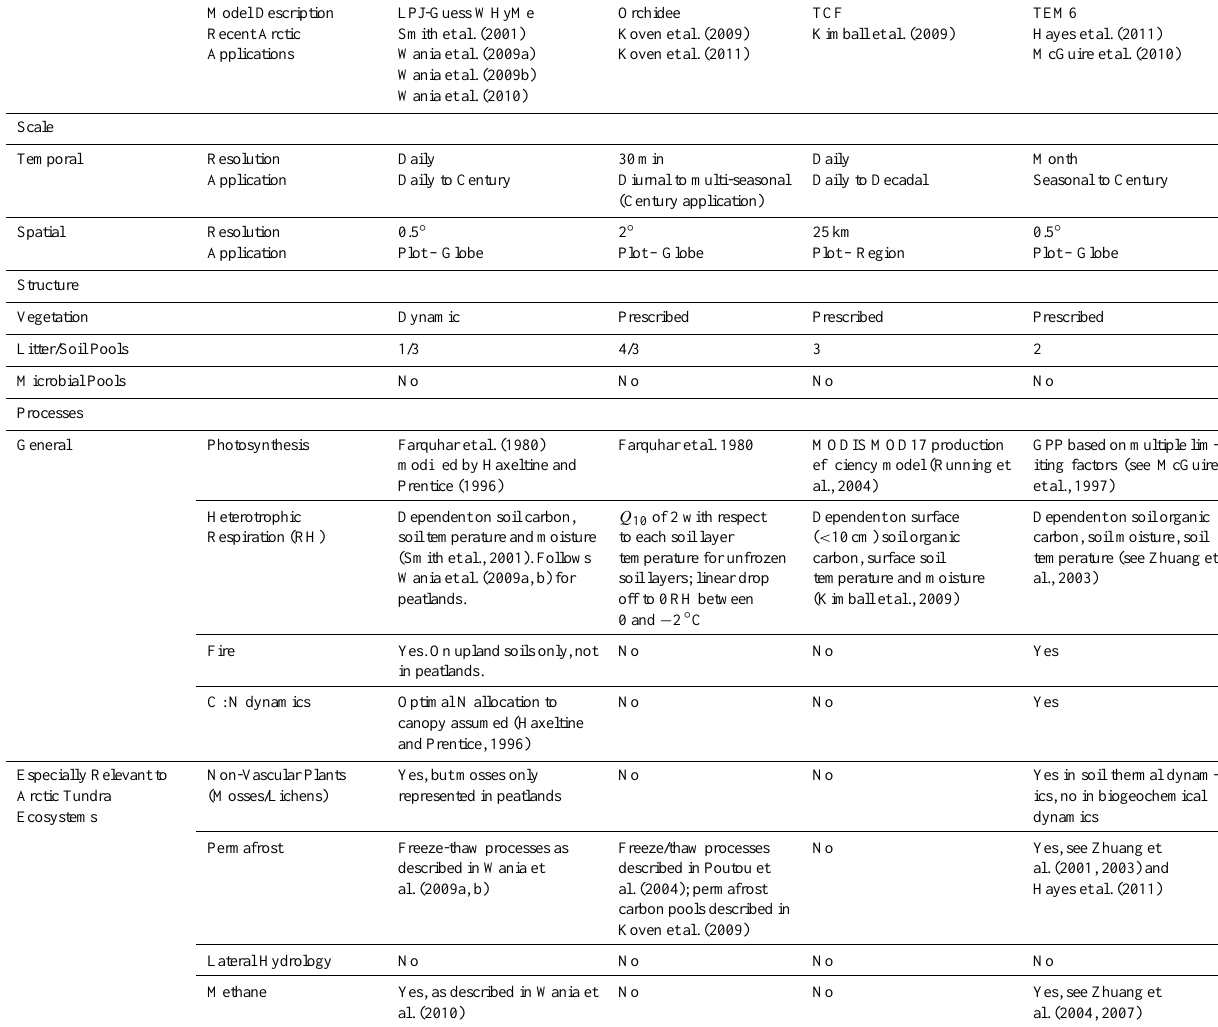
Table 2. Description of process-based models compared in this study. See Supplement 2 for additional